Question: In a single sentence, describe what this figure presents.
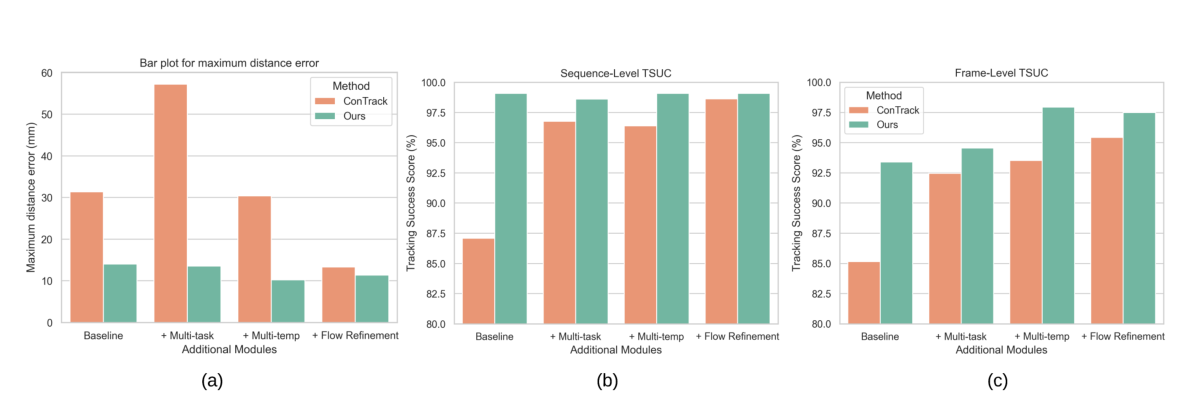
Answer: Comparison of robustness between our method and different versions of Contrack, via (a) maximum distance error (↓), (b) sequence-level TSUC (↑) and (c) frame-level TSUC (↑).